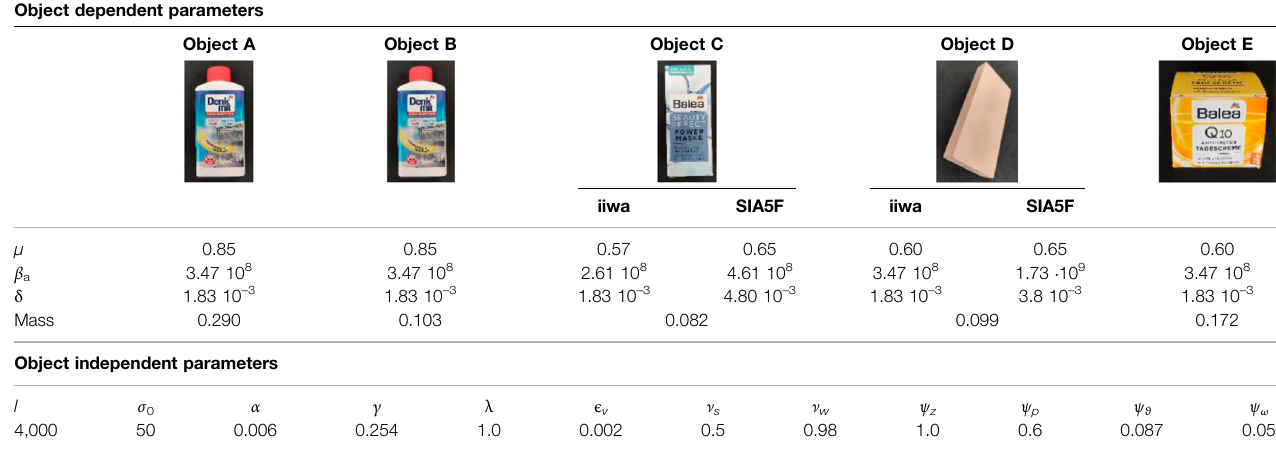
TABLE 1 | Parameters of the algorithm (SI units). The friction model parameter μ , δ , and c appear in Eq. 8 and β a in Eq. 11 . Note that: object mass is not used in the algorithms, it is reported for the reader ’ s convenience in the interpretation of the results; the parameter δ is object independent for rigid objects, for partially deformable objects it has to be estimated for each object; object B is the same as object A but the bottle is empty; the parameter α is reported for a sampling rate of 500